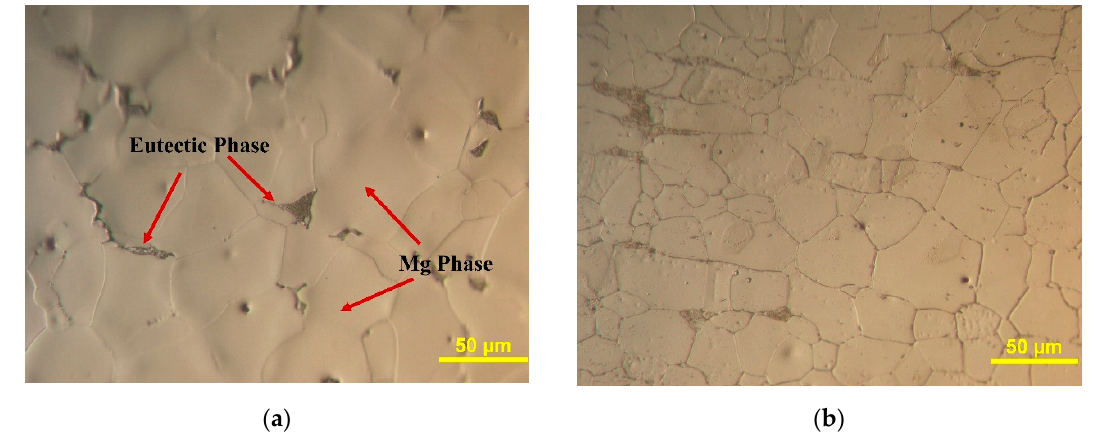
Figure 1. The optical microscopy images of WE43 in ( a ) as-cast ( b ) T5 condition.